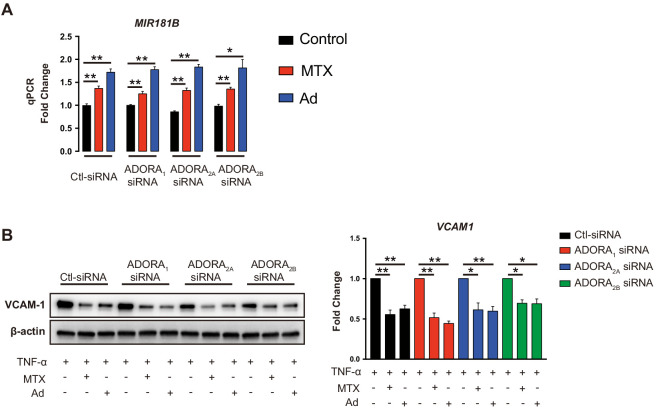
Silencing of adenosine receptor A1, A2A, or A2B did not affect methotrexate (MTX) or adenosine-induced MIR181B expression.(A) Expression analysis of MIR181B in HUVECs transfected with siRNA to scrambled control, ADORA1, ADORA2A, or ADORA2B in the presence or absence of MTX (10 µM) or Ad (50 µM) for 4 hr. (B) VCAM-1 protein quantification by western blot as described above, but in the presence of TNF-α (10 ng/ml) for 8 hr. A and B, n = 3. *p<0.05; **p<0.01. All values represent mean ± SEM.